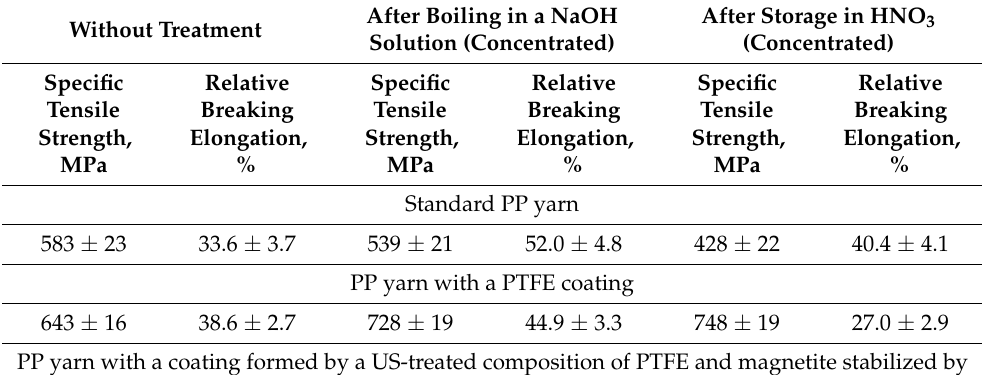
Table 5. Tensile strength and elongation of PP yarns with a PTFE coating after boiling in a sodium hydroxide solution (5 mol/L) for 3 h and storage in concentrated nitric acid for 24 h at a temperature of 25 ◦